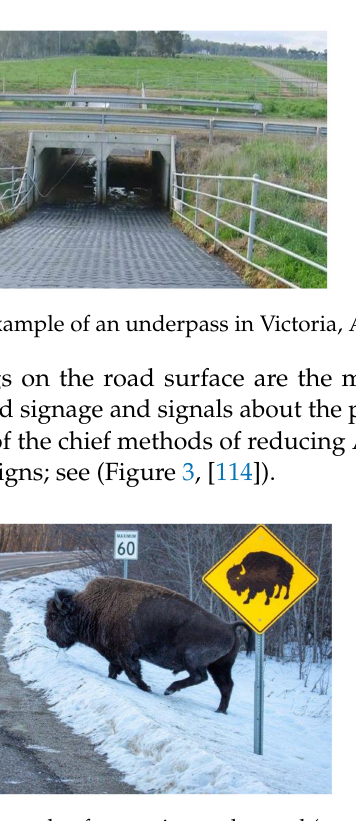
Figure 3. An example of a crossing at the road (name unavailable) surface in the